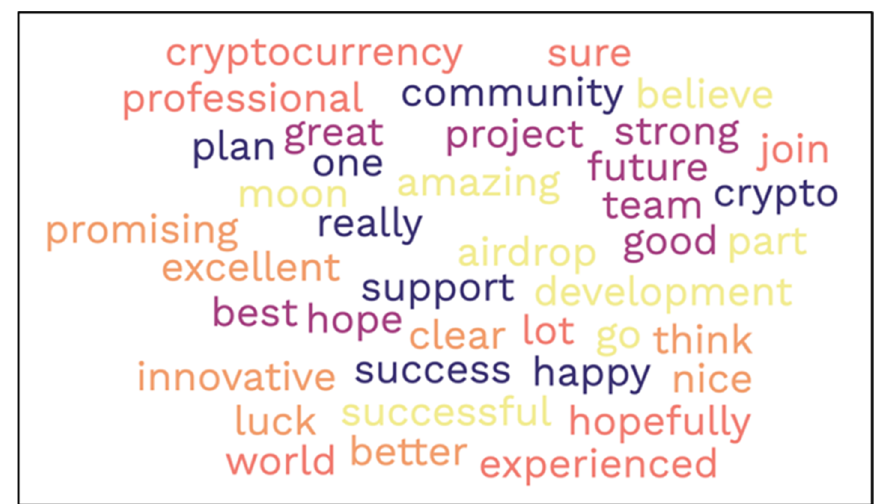
Figure 5. Most frequent words of the most dominant tweets.